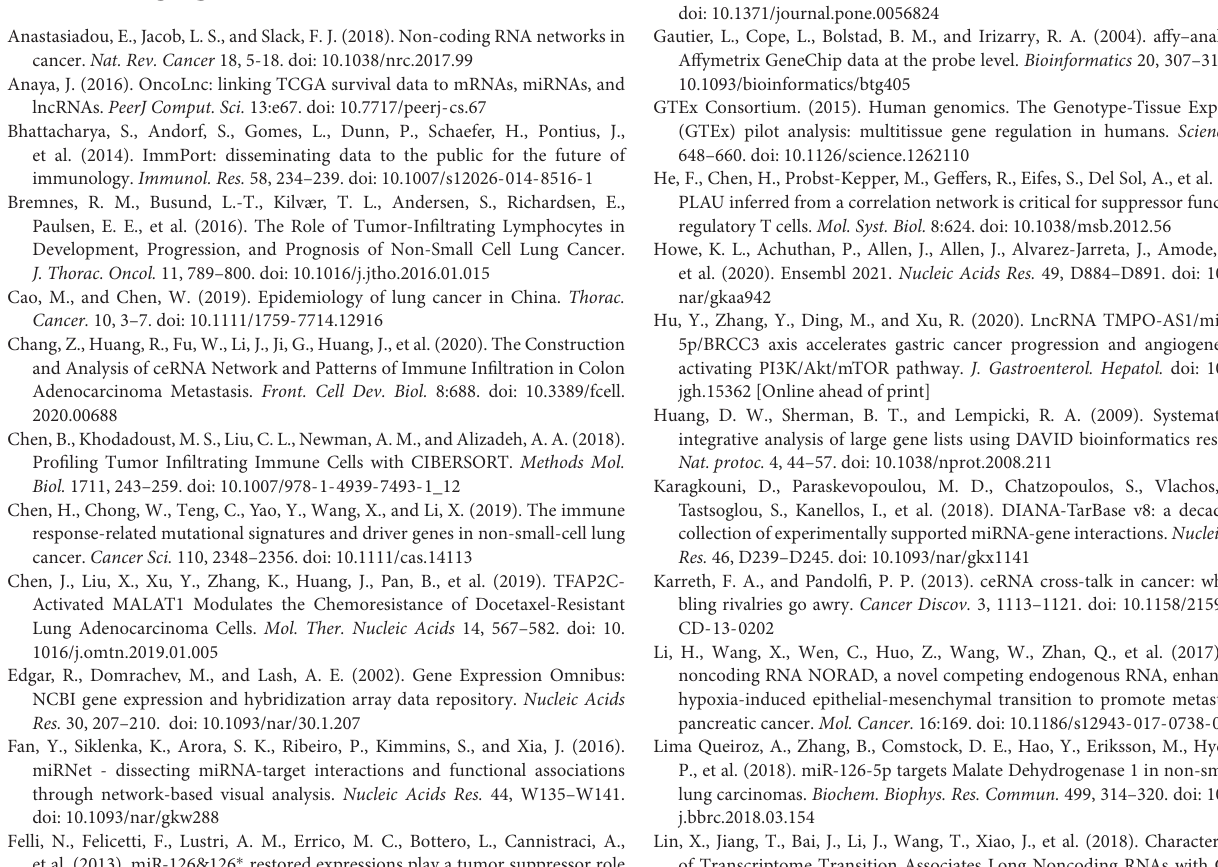
Supplementary Figure 3 | Validating the prognostic value of hub IRGs through OncoLnc database. (A–F) Validating prognostic roles of PLUA, SPP1,